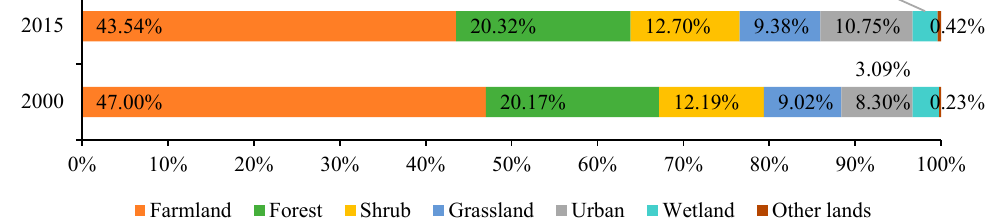
Figure 4. Area changes and area change ratios of ecosystems in the Beijing–Tianjin–Hebei urban agglomeration from 2000 to 2015. 3.1.2. Ecosystem Distribution and Transfer Ecosystems in the Beijing–Tianjin–Hebei urban agglomeration have obvious spatial differences. The forests, shrubs, and grasslands are mainly distributed in the Yanshan Mountains in the north and the Taihang Mountains in the west; the wetlands are mainly distributed in the Bohai Bay area, and the rest of the wetlands are scattered; the farmland is mainly distributed in the vast plain in the southeast; and the urban areas are mainly distributed in municipalities directly under the central government and prefecture-level cities. Among them, Beijing and Tianjin are the most concentrated and widely distributed (Figure 5A). Sorted in descending order of area, the spatial distribution of ecosystem change types that cumulatively account for the top 99% of the total ecosystem area changes from 2000 to 2015 is shown in Figure 5B. It can be seen that the newly added urban land is mainly distributed in the eastern and southern plains, with the most signif- icant land urbanization expansion taking place in Beijing and Tianjin (Figure 5B).